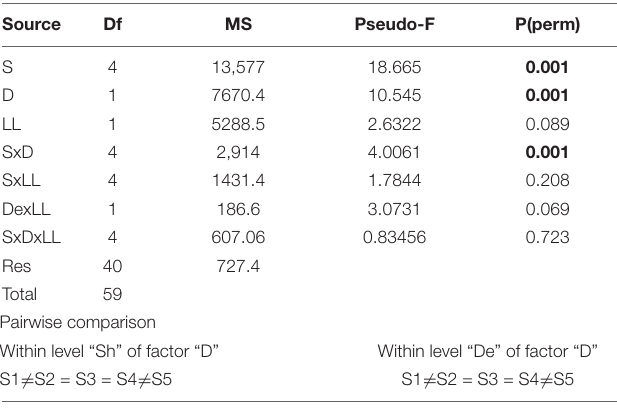
TABLE 2 | Results from permutation analysis of variance (PERMANOVA) analysis of vertical